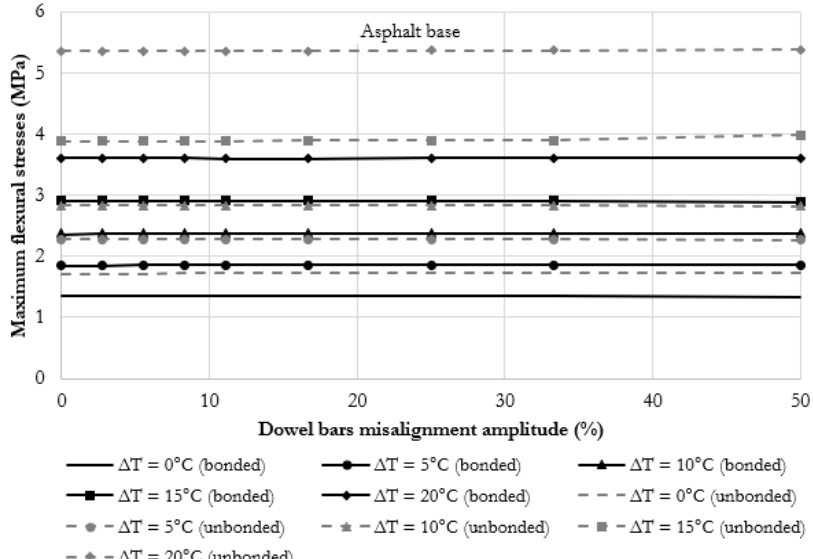
Figure 11. Flexural stresses in concrete slabs placed over asphalt base according to dowel bars uniform horizontal skew and thermal